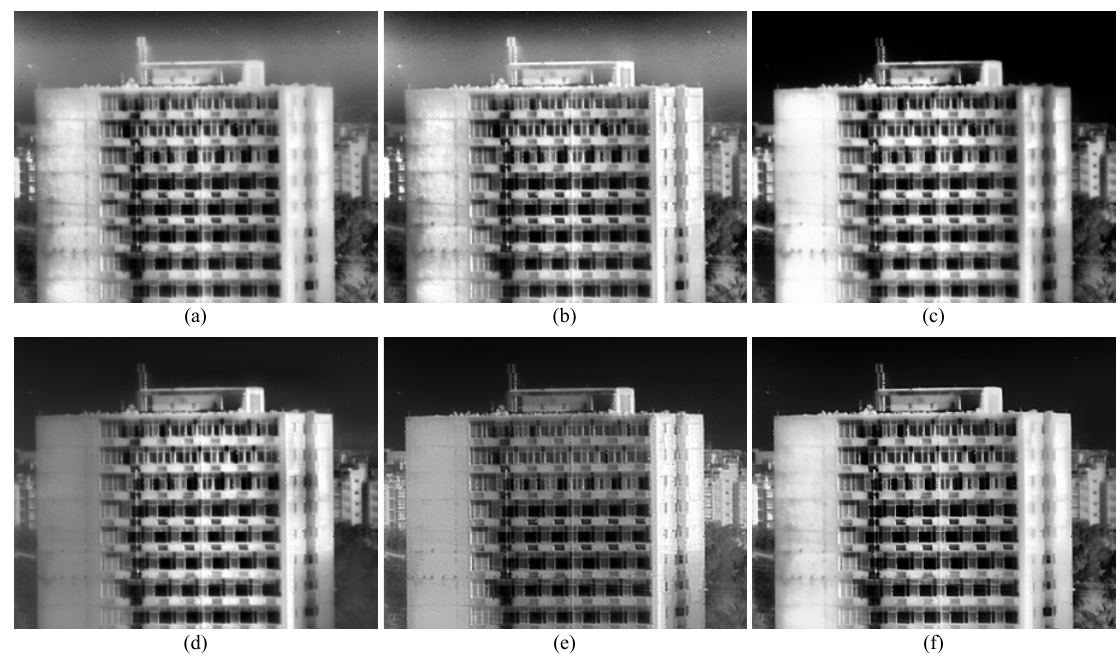
Figure 10. Enhancement results for Building2. ( a ) CLAHE, ( b ) BCCE, ( c ) ABMHE, ( d ) LGGSF, ( e ) GLHS,